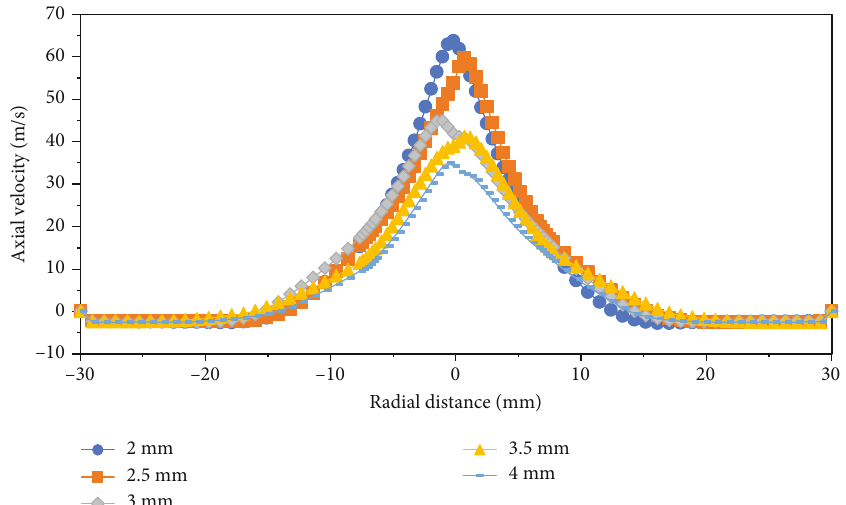
Figure 15: Axial velocity distribution of di ff erent blade thickness in h / d = 8 .